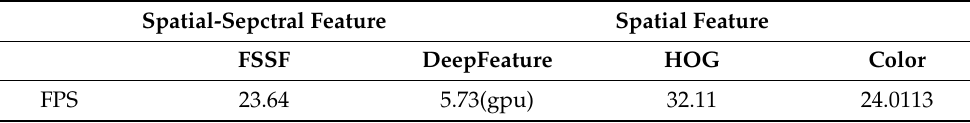
Table 3. FPS comparison between spatial feature and spatial-spectral feature with same